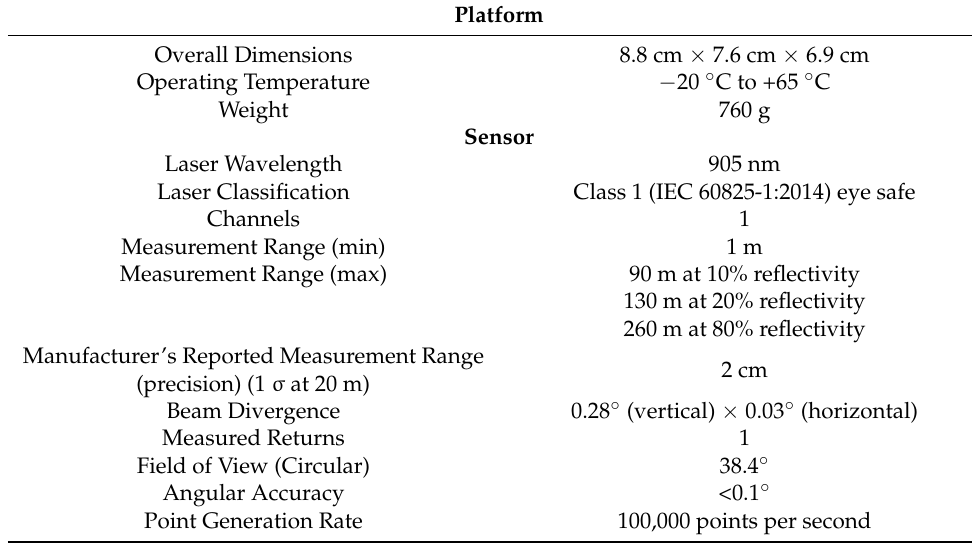
Table 2. Livox ® Mid–40 Select Specifications [15].